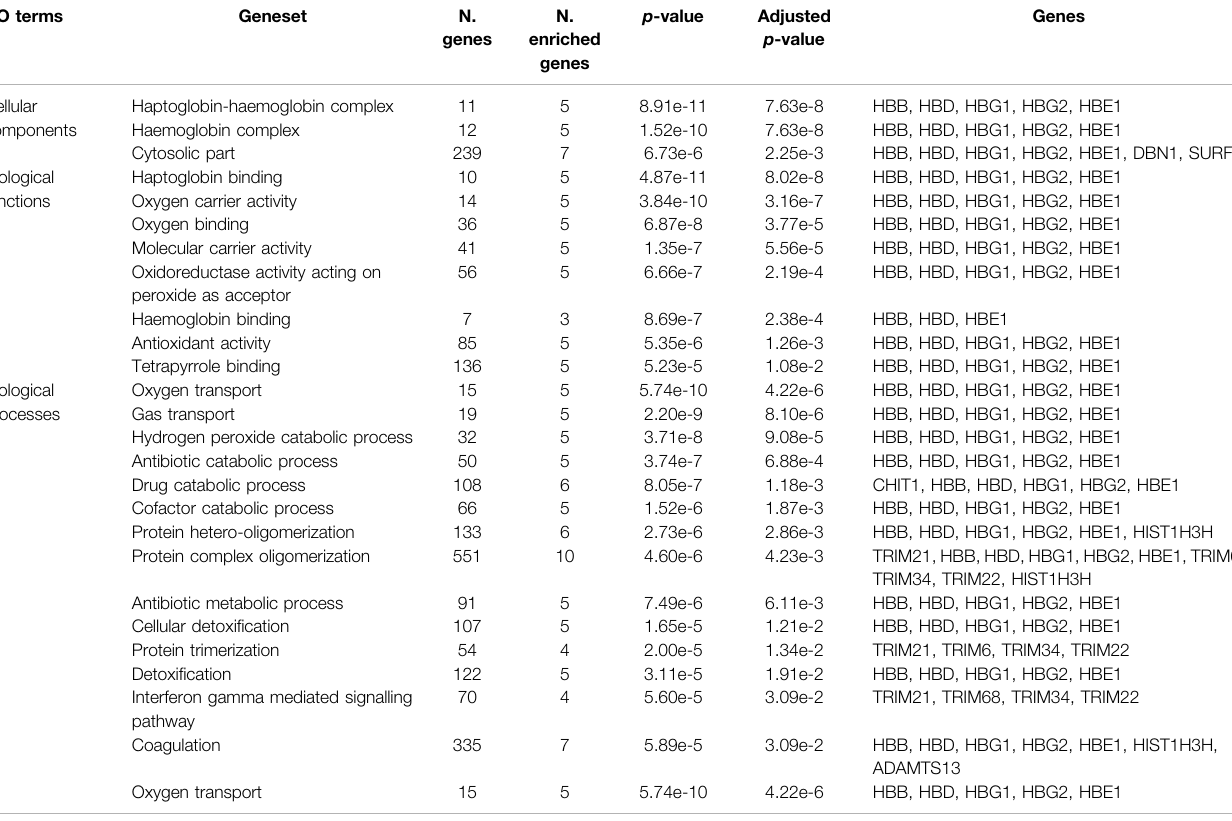
TABLE 2 | Gene enrichment results of functionally annotated genes in malaria genomic risk loci identi fi ed by FUMA method.